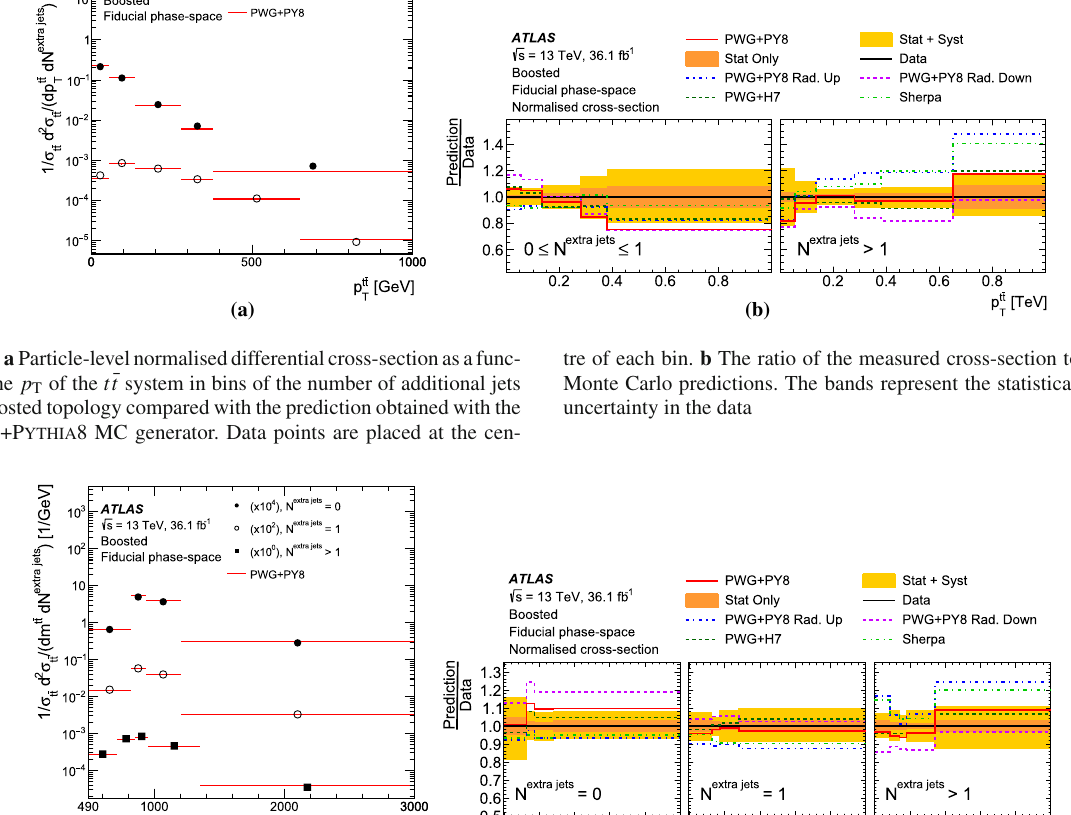
Powheg + Pythia8 MC generator. Data points are placed at the centre ofeachbin. b Theratioofthemeasuredcross-sectiontodifferentMonte Carlo predictions p -value are calculated using the covariance matrix of the measured spectrum. The NDF is equal to the number of bins in the distribution minus